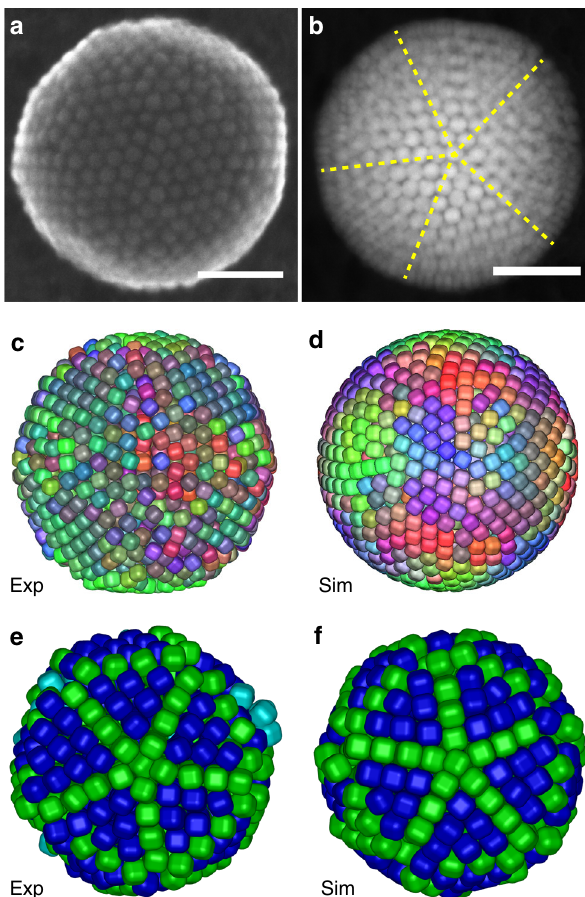
Fig. 3 SPs consisting of rounded nanocubes. a Secondary electron-STEM (SE-STEM) image of a SP containing rounded Fe x O/CoFe 2 O 4 nanocubes, b 2D HAADF-STEM image of a SP of Fe x O/CoFe 2 O 4 nanocubes for tomography study, where the fi vefold symmetry of a Mackay icosahedron, is readily visible. c , e experimental and d , f simulation results ( α = 0.3) of c , d surface and e , f core termination of a SP resulting from the SA of spherical con fi ned rounded Fe x O/CoFe 2 O 4 nanocubes, which exhibits Mackay icosahedral symmetry. Note that different colors in c and d represent different orientations of the rounded cubes at the surface. For an interactive 3D view of c – e , see Supplementary Data 3 – 5, respectively. Scale bars,